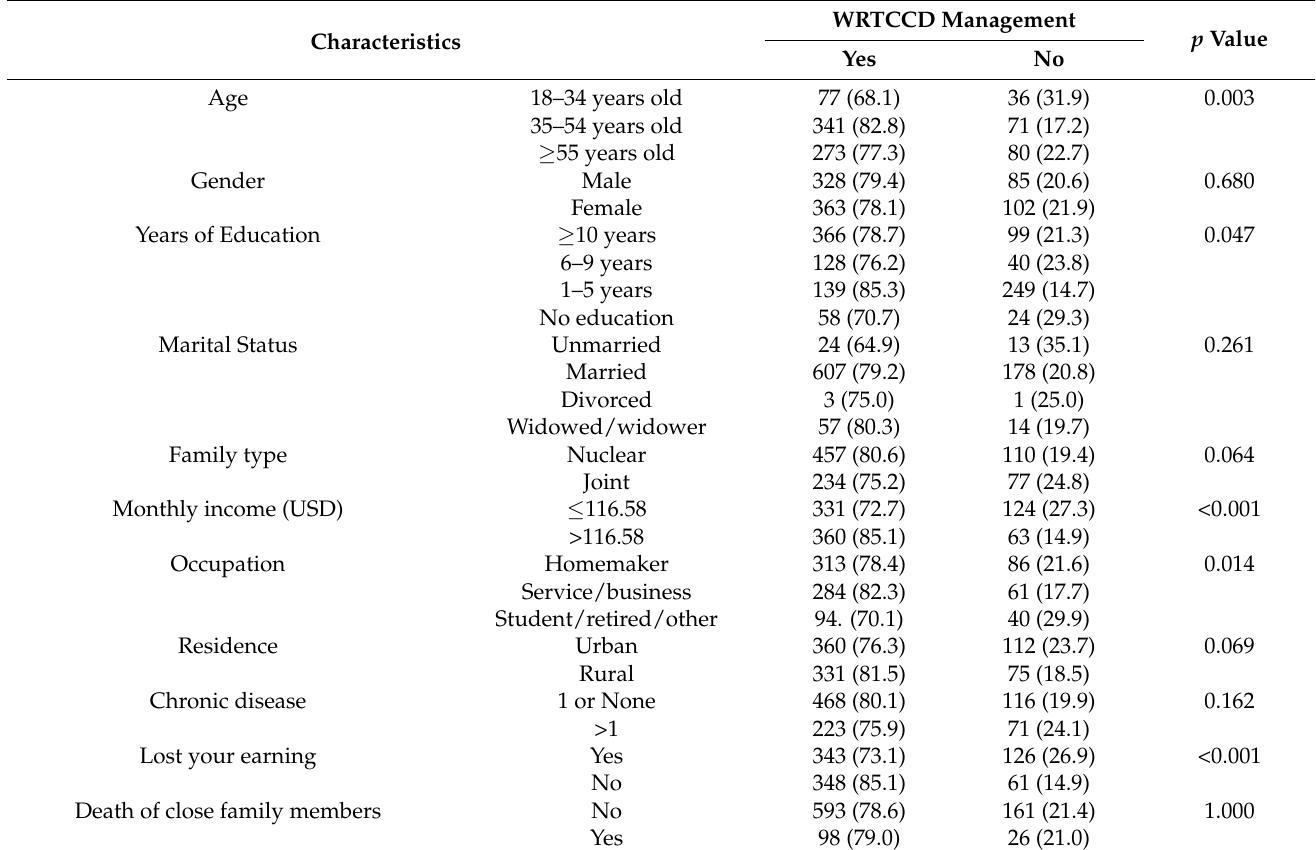
Table 4. Association between WRTCCD with sociodemographic characteristics (N =